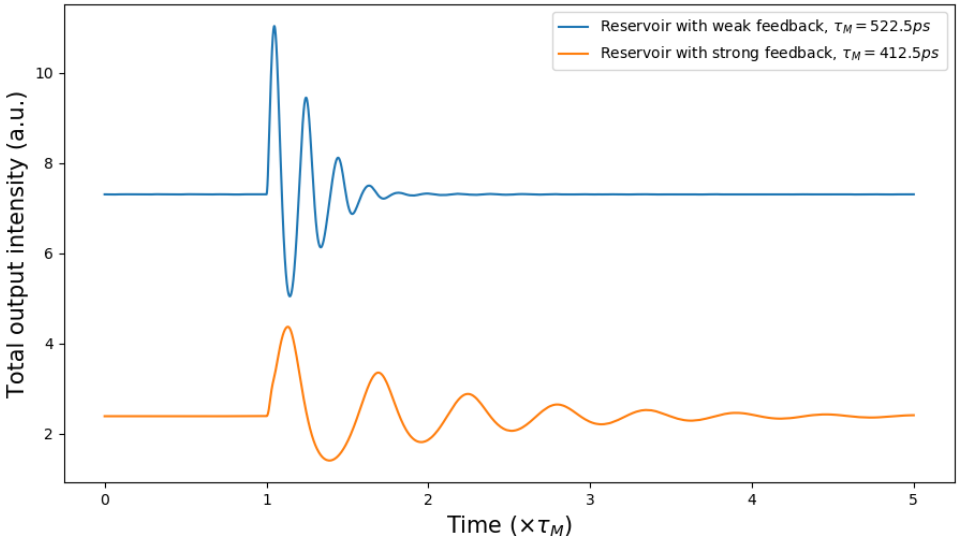
Figure 6. A reservoir with weak and another one with a strong feedback rate are prepared with a constant injection of zeros. A perturbation is introduced in the first node of the second datapoint and we observe how this perturbation ripples through the sum of the modal intensities. Parameters for the reservoir with weak feedback: η = 1 ns − 1 , τ D = 150 ps, N = 95, θ = 5.5 ps, J 0 = 7.5 J th and δ J = 9.5 J th and for the reservoir with strong feedback: η = 100 ns − 1 , τ D = 15 ps, N = 55, θ = 7.5 ps, J 0 = 3 J th and δ J = 8 J th